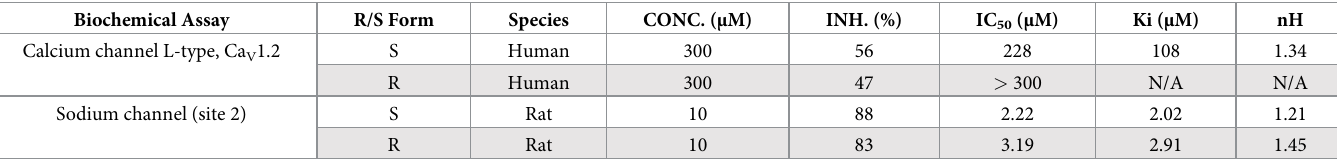
Table 4. Biochemical potency assessment of R-Vera and S-Vera on Ca V 1.2 and sodium channel (Site 2). R-Vera and S-Vera had similar potency. Biochemical Assay Calcium channel L-type, Ca V